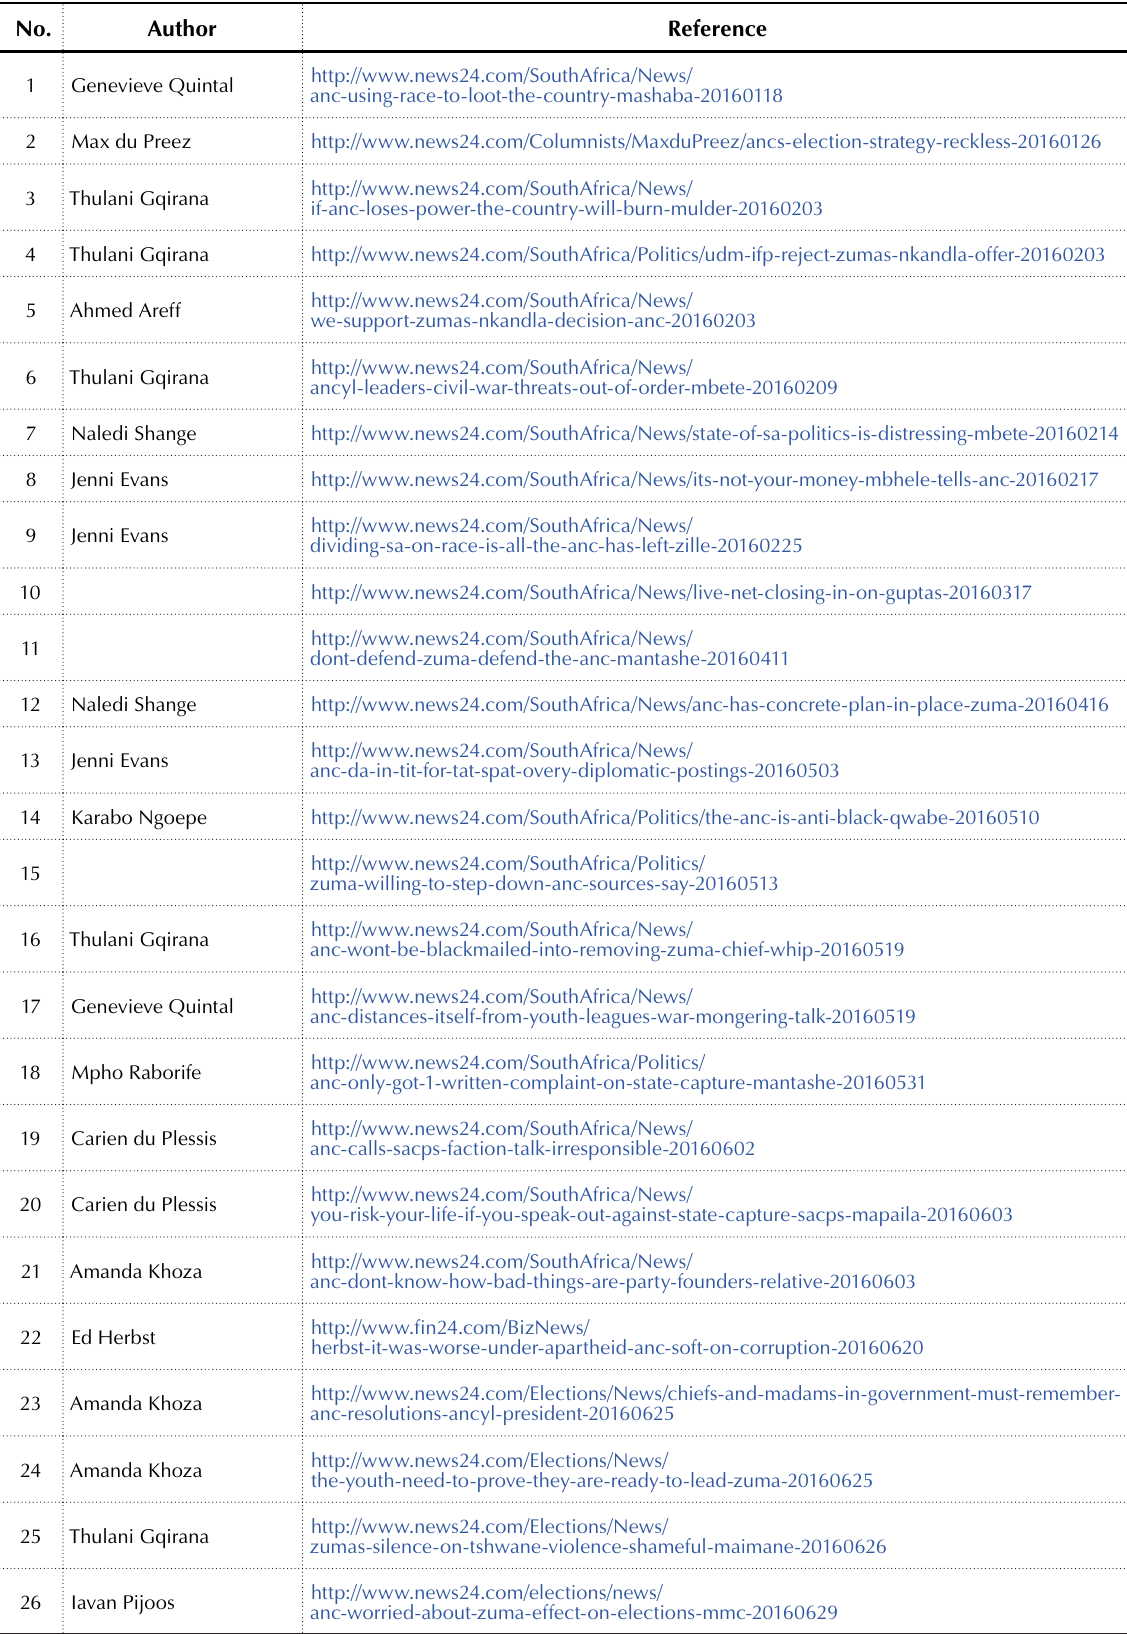
Table 1B. Political macro-environment